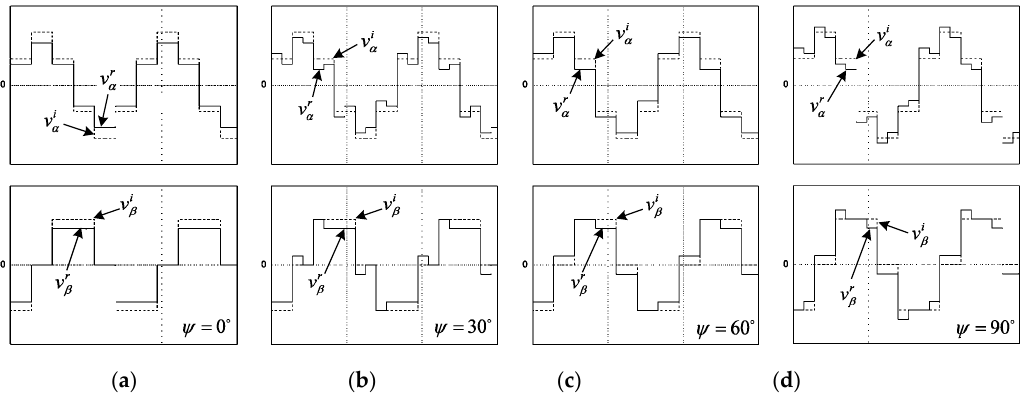
Figure 16. v i α , v i β and v r α , v r β waveforms on the stationary reference frame according to the phase ψ